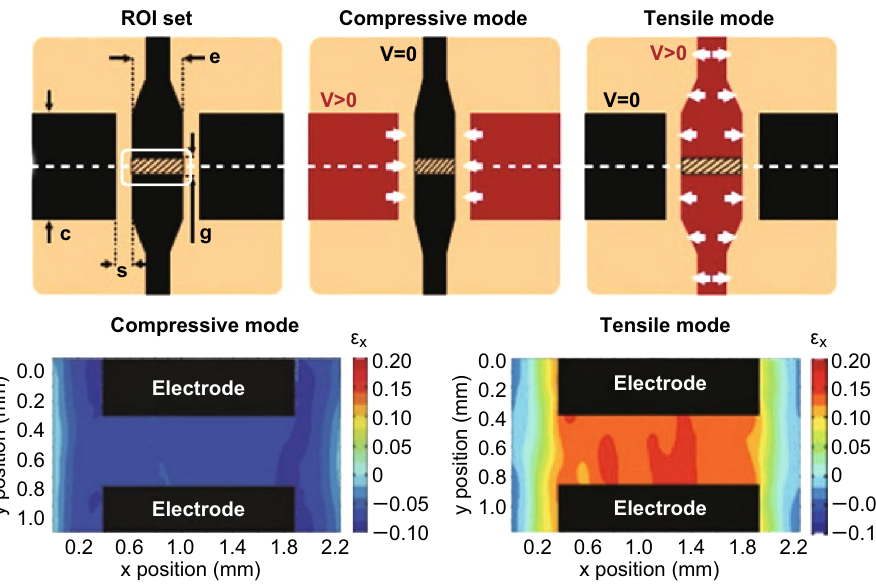
Fig. 4 Example of characterizing DEA system via DIC. The white rectangle is region of interest (ROI) set. Strain distribution of both compres- sive and tensile mode can be obtained through DIC. Adapted from Ref. [78] with